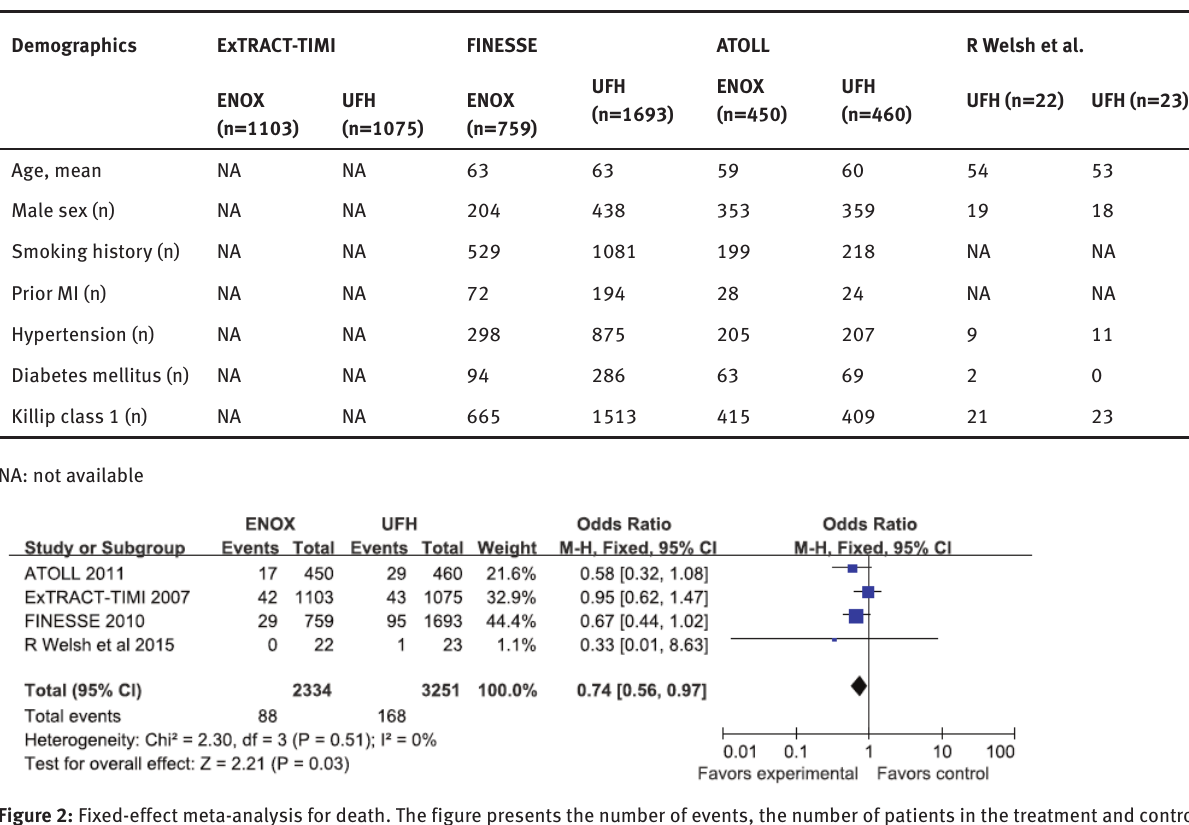
Table 2: Patient characteristics in each randomized trial.